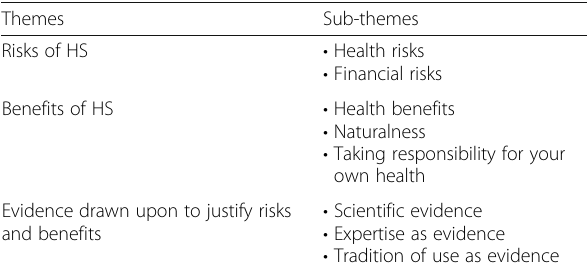
Table 2 Summary of themes and sub-themes from thematic analysis of the